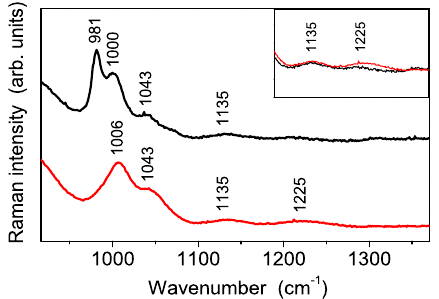
Figure 7. Raman spectra of the synthesized sample before (red) and after (black) the storage in high humidity environment. Inset: direct comparison of the 1225 cm − 1 peak intensity.